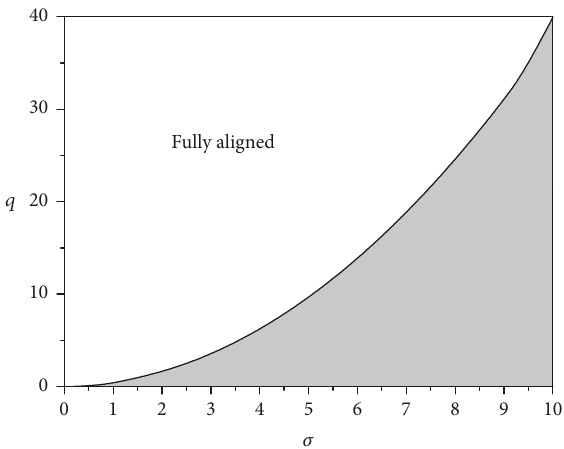
Figure 3: Curve that separates the regions where the applied electric field aligns the director in the vertical direction along the whole cell (fully aligned region) and the shaded region where the boundaries still influences the direction of the director which is position dependent as shown in Figure